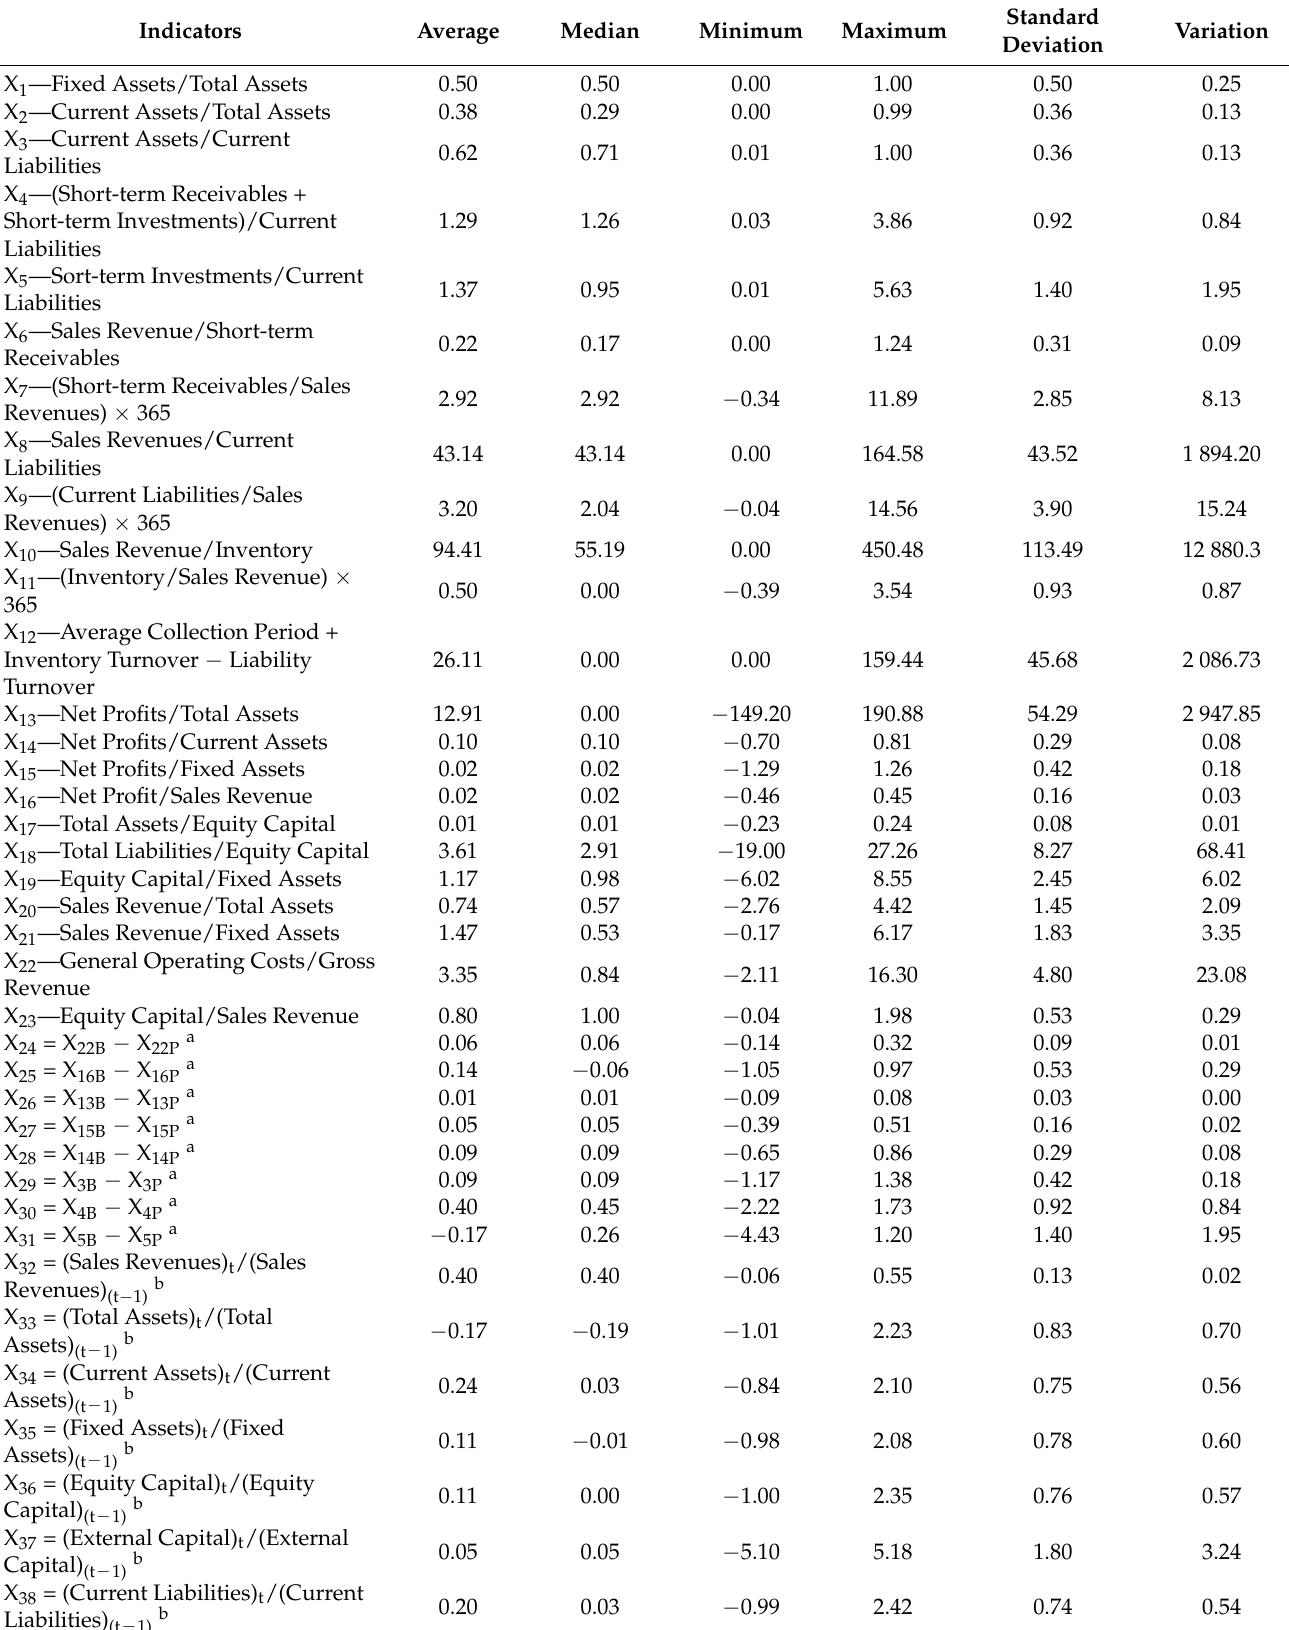
Table 1. Descriptive statistics of financial indicator of analyzed